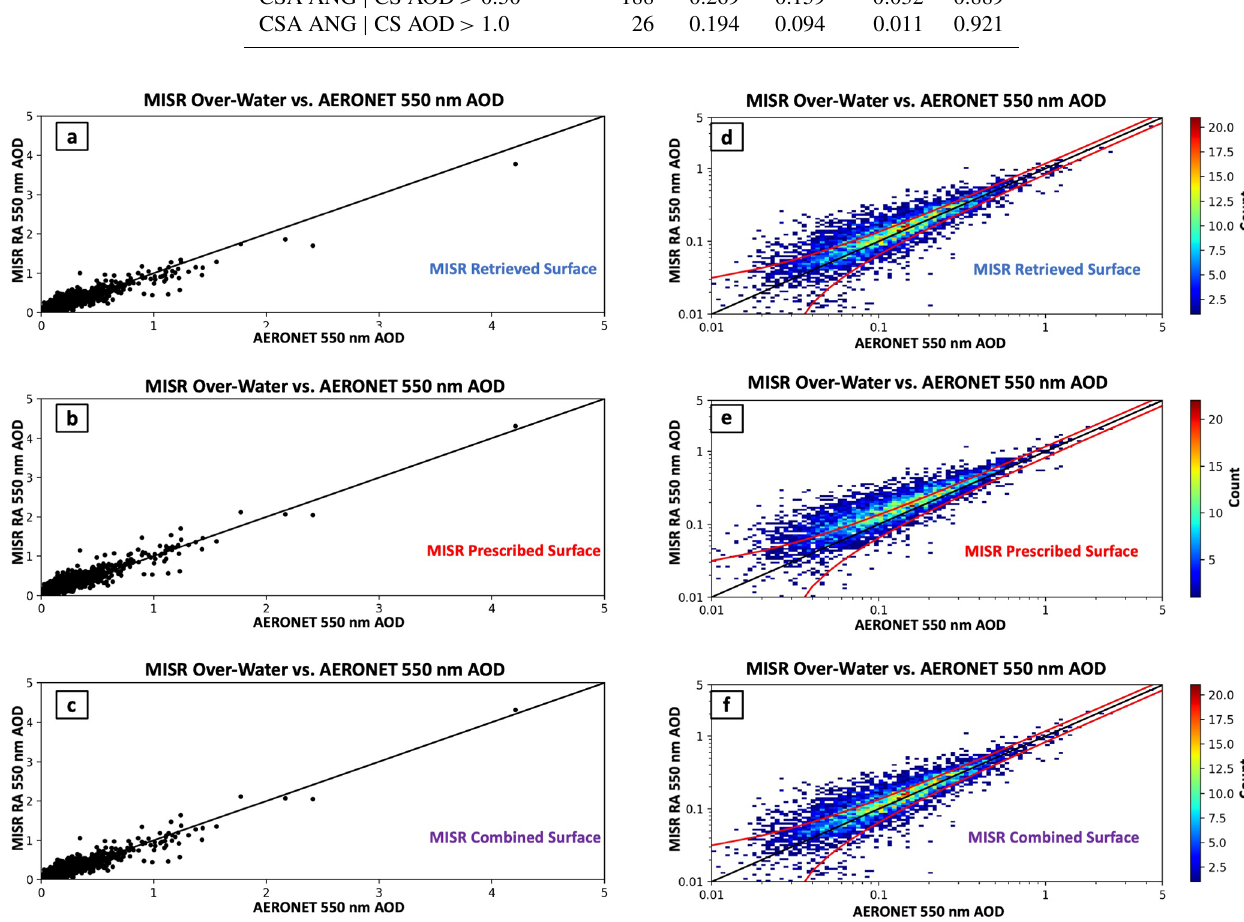
Figure 6. Same as Fig. 2, except for the MISR over-water retrieval.